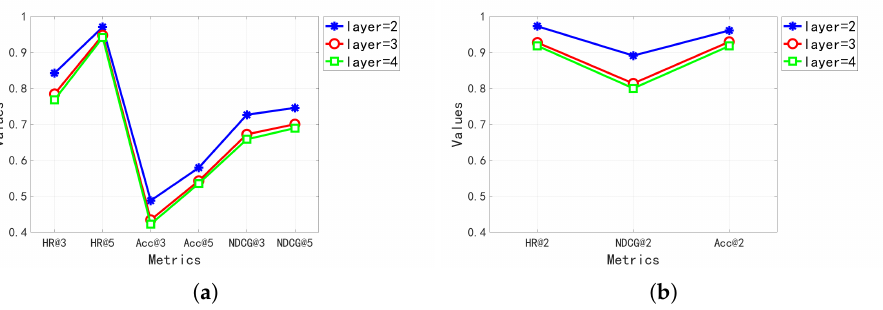
Figure 7. Performances of Different Layers on Two Datasets. ( a ) Telecom Dataset . ( b ) Talking Dataset